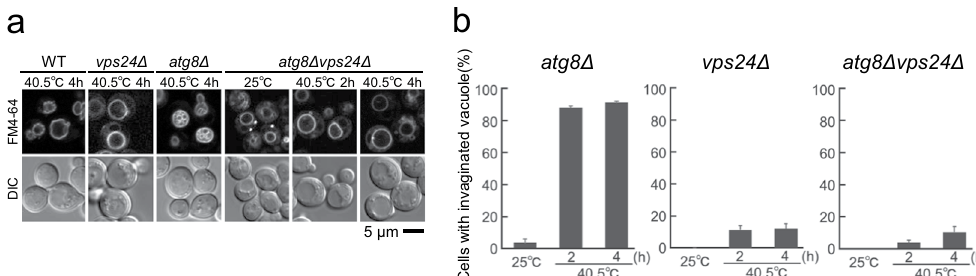
Figure 4. Relationship of Atg8 with ESCRT factors. ( a ) Vacuolar morphologies of wild-type, vps24 Δ , atg8 Δ , and atg8 Δ vps24 Δ cells at 25 °C and 40.5 °C. Because FM4-64 fluorescence was fainter in cells at 25 °C than in cells after heat stress, the contrast of images of cells at 25 °C was enhanced. Images with the same contrasts at 25 °C and 40.5 °C are shown in Fig. S6b. ( b ) Quantification of cells with invaginated vacuoles. Cells with invaginated vacuole structures were counted among a total of 50 cells in each experiment, and the three independent experiments were performed. The mean values of the ratio and standard errors (SE) are shown. Statistical significance was not observed (p > 0.05) for vps24 Δ cells vs. atg8 Δ vps24 Δ cells both at 2 and 4 h at 40.5 °C,